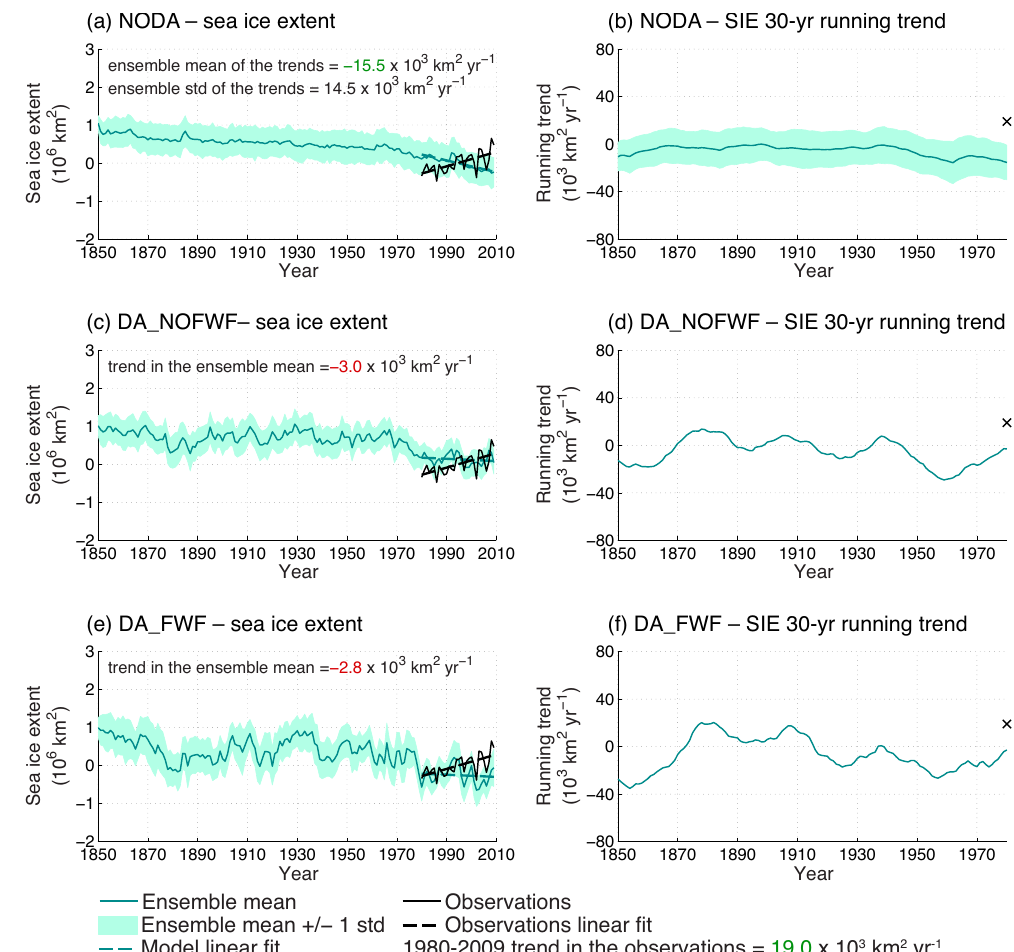
Figure 2. (a, c, e) Yearly mean sea ice extent anomalies with regard to 1980–2009 and (b, d, f) 30-year running trend in sea ice extent. Results are from (a, b) the simulation without data assimilation (NODA), (c, d) the model simulation that assimilates anomalies of surface air temperature (DA_NOFWF) and (e, f) the model simulation that assimilates anomalies of surface air temperature and that is forced by an additional autoregressive freshwater flux following Eq. (1) (DA_FWF). The model ensemble mean is shown as the dark green line surrounded by one standard deviation shown as the light green shading. Observations (Comiso, 1999) are shown as the black line (cross) in (a, c, e) (in b, d, f ). The green (black) dashed line shows the linear fit of the model simulation (observations) in (a, c, e) . The values of the trend indicated in ( a, c, e ) correspond to the ensemble mean of the trends, computed over the period 1980–2009, along with the ensemble standard deviation for NODA. Trends that are (non-)significant at the 99% level are shown in green (red).